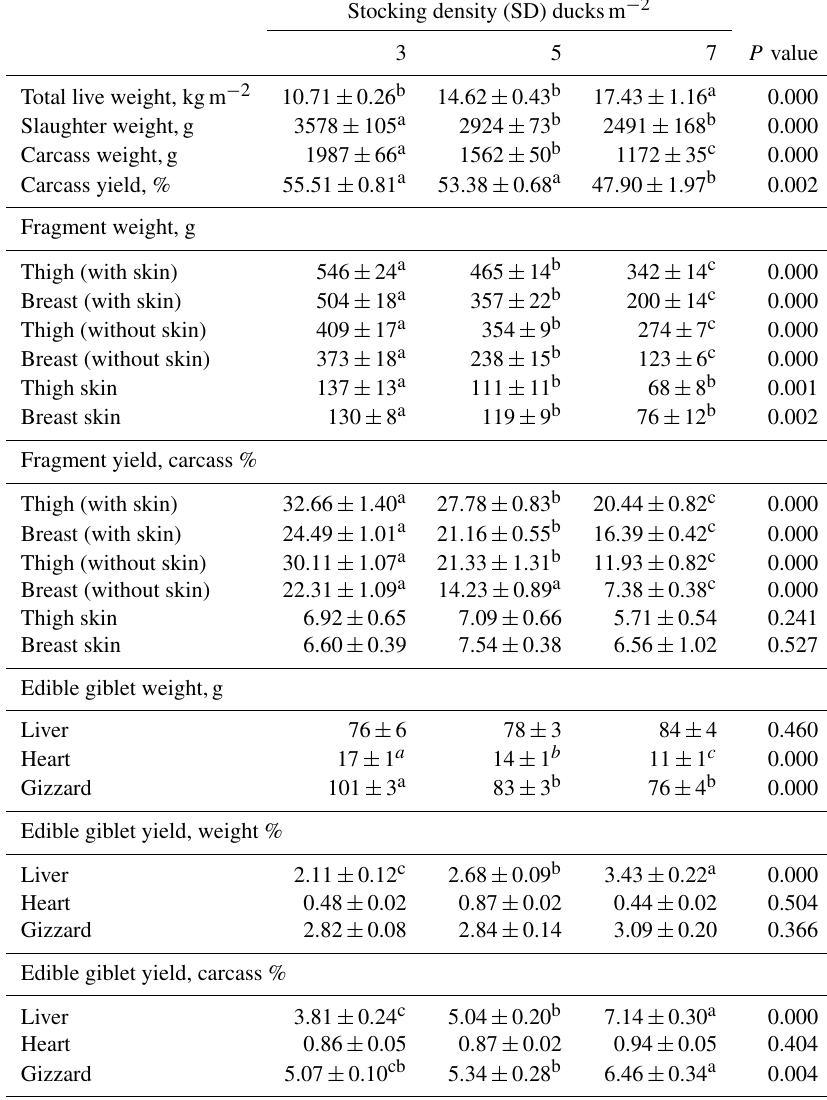
Table 2. The effects of stocking density on the slaughter performance of Pekin ducks (mean ±